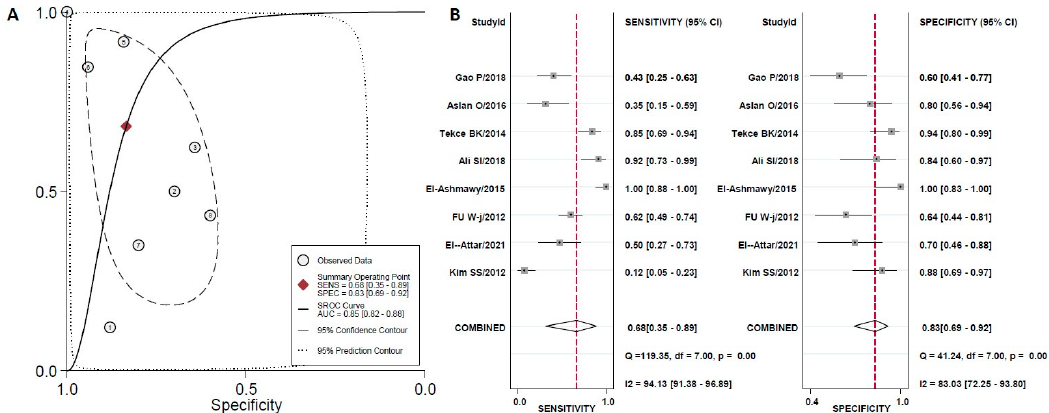
Figure 2. ( A ) The hierarchical Summary Receiver Operating Characteristic curve curve of uKIM-1to discriminate controls (healthy individuals) from normoalbuminuric T2DM patients. The straight line represents the hSROC curve; the circle represents each of the analyzed studies; the diamond shape represents the point estimate to which overall sensitivity and specificity correspond. ( B ) Forest plot for sensitivity and specificity.